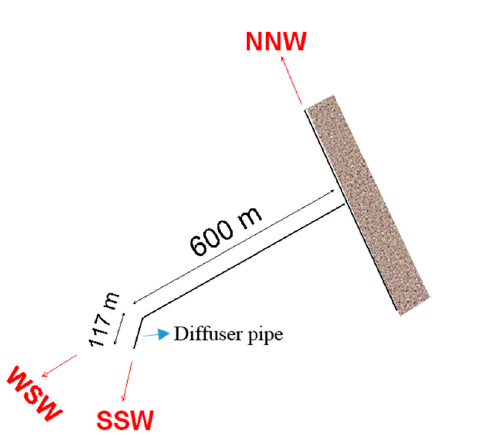
Figure 11. Sea outfall system.